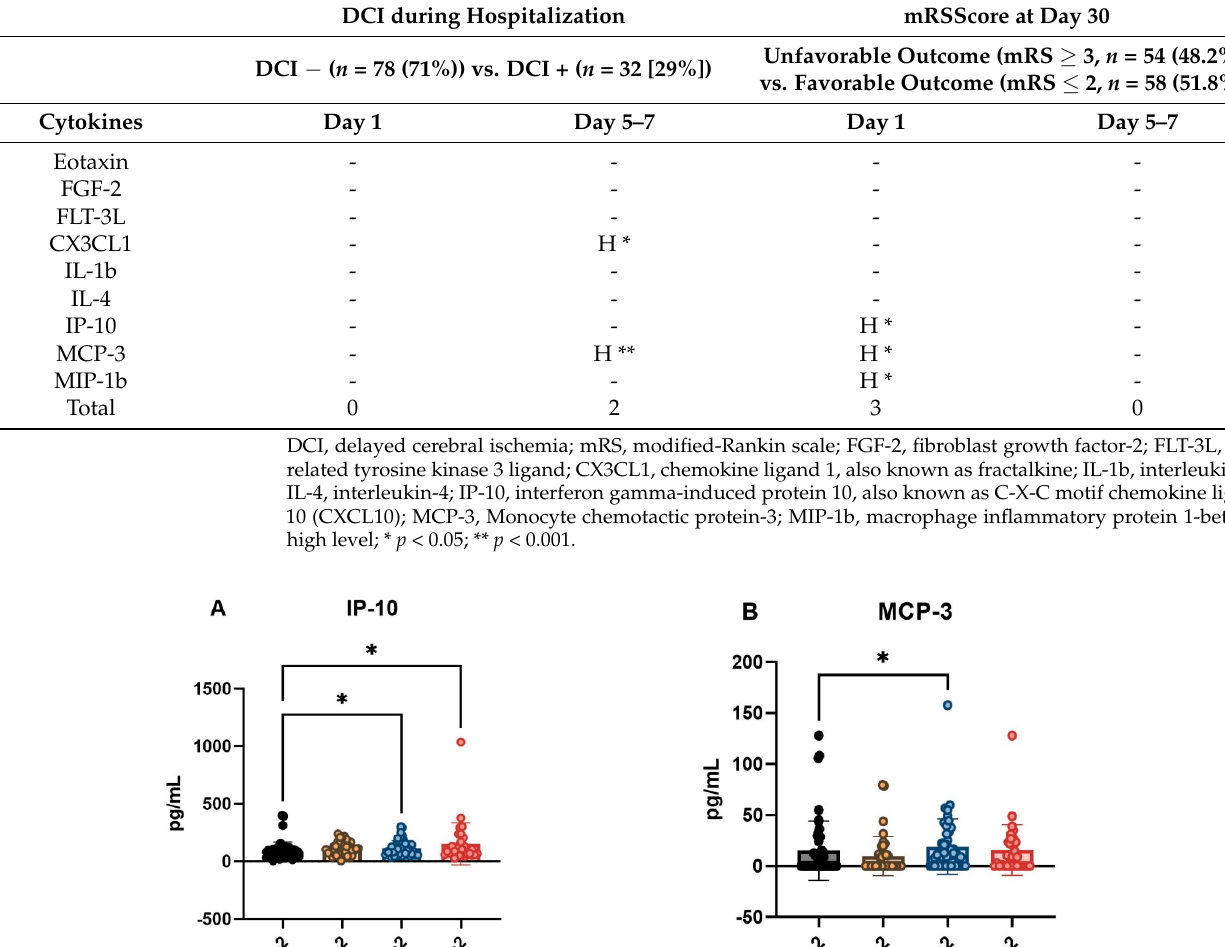
Figure 1. Characteristics of serum biomarker levels in different clinical subgroups in patients with aSAH. Correlation of the functional outcome with the investigated biomarkers, in the case of IP-10 ( A ), MCP-3 ( B ) and MIP-1b ( C ). Correlation of MCP-3 ( D ) and CX3CL1 ( E ) measured at T2 with DCI. Association of IL-4 ( F ) with TCD positivity. The functional outcome was examined 30 days after admission and characterized on the modified Rankin scale (mRS). Biomarker sampling times: Day 1, 24 h after aSAH, Day 5–7, 5–7 days after aSAH. DCI, delayed cerebral ischemia; aSAH,